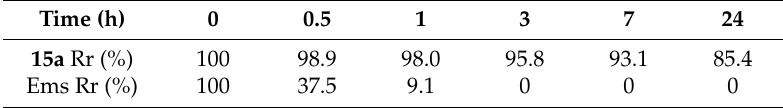
Table 4. Metabolic stability of 15a in whole blood.